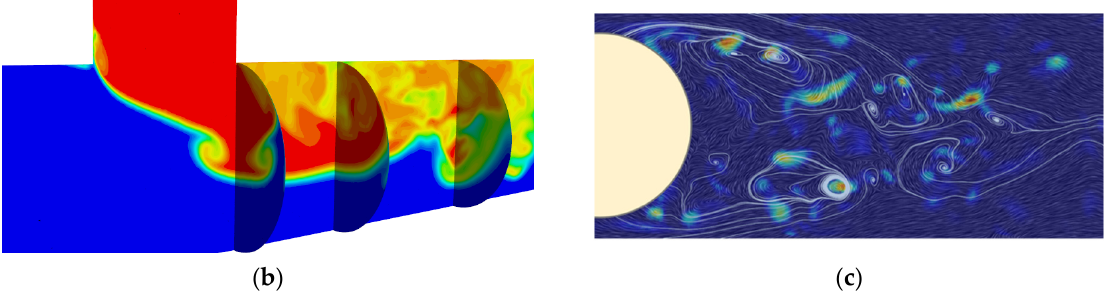
Figure 5. Transient flow structures ( a ), Kelvin-Helmholtz instabilities ( b ), Karman vortex street—Top view ( c ). Contours ( a , b ) are coloured by transient temperature; contour ( c ) is coloured by transient Q-criterion > 0. Contour ( a ) shows the isosurface of Q-criterion = 50 s − 1 ; streamlines in contour ( c ) are generated by transient velocity.